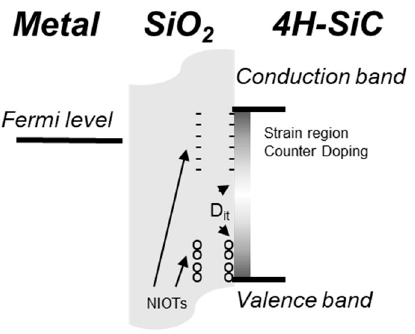
Figure 3. Graphical representation of the SiO 2 / 4H-SiC interface, indicating the regions of interest and interface states and oxide traps.